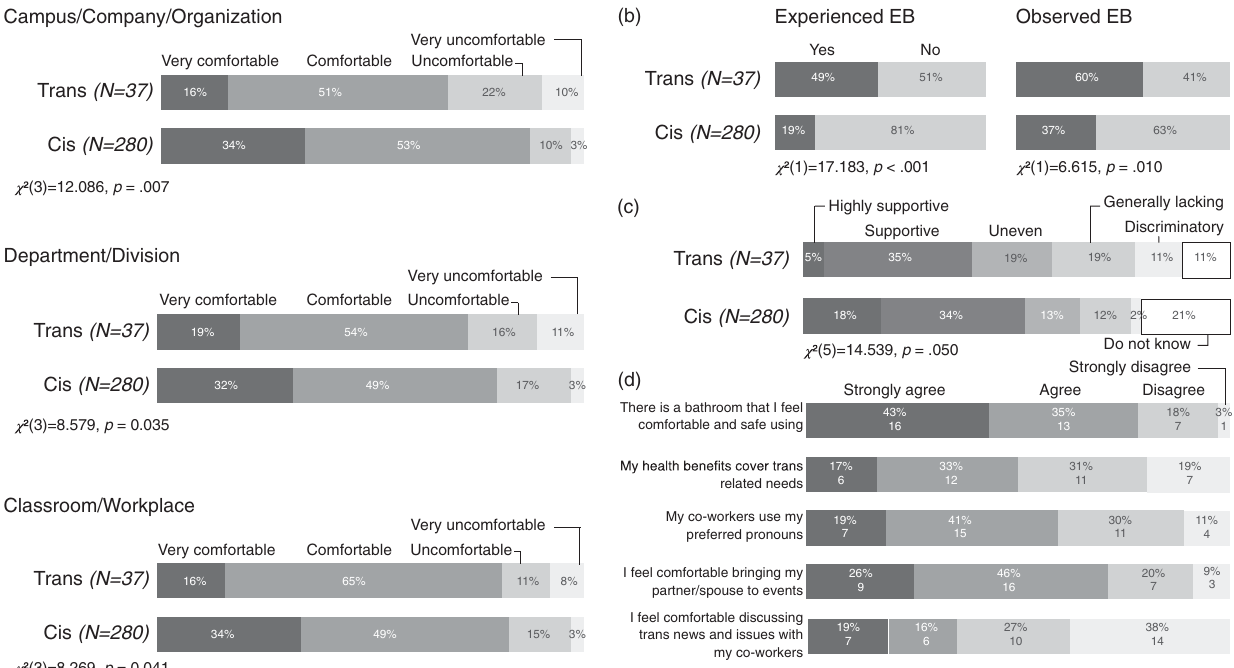
FIG. 5. Climate responses by trans status. (a) Comfort level in different institutional contexts. (b) Experience and observation of exclusionary behavior. (c) Perceptions of institutional policies. (d) Responses to trans-specific climate